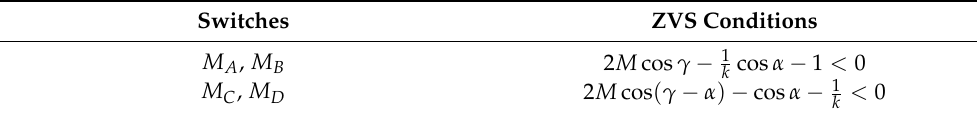
Table 1. The ZVS conditions for the